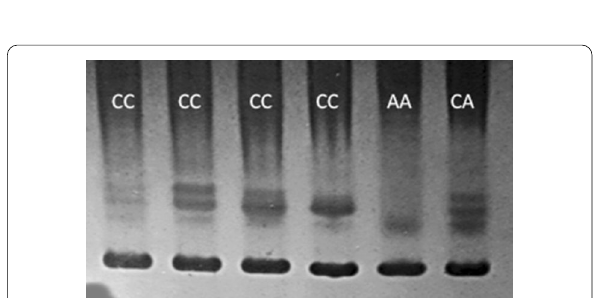
Fig. 2 SSCP non‑denaturing polyacrylamide gel electrophoresis of ovine ADIPOQ gene (exon 1) PCR fragments, which appeared three PCR‑SSCP banding patterns, CC, CA, and AA in Awassi ewes